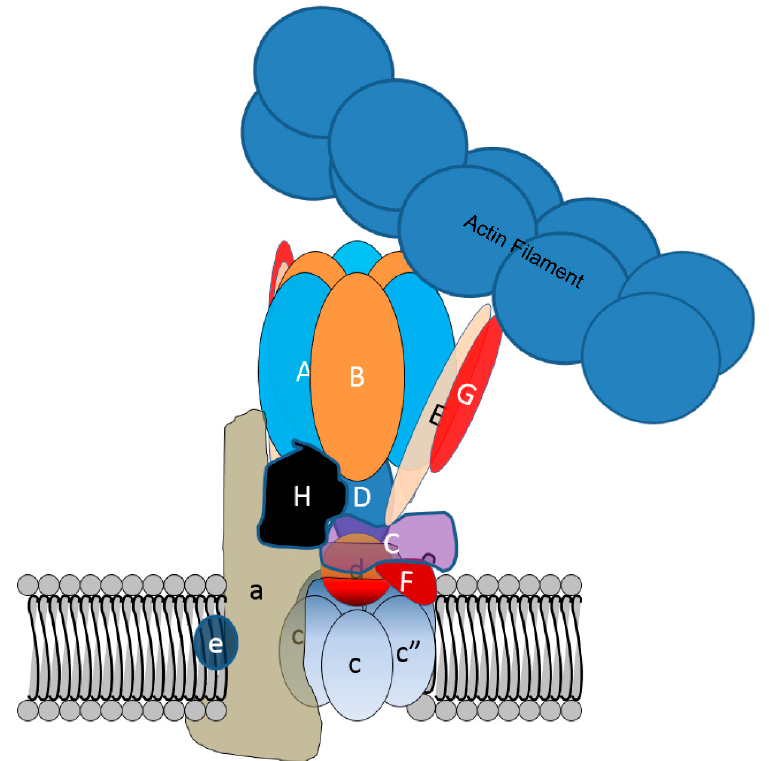
Figure 4. Despite a high affinity actin ‐ binding site in the B ‐ subunit of V ‐ ATPase, normally V ‐ ATPase does not bind microfilaments in cells. This is likely due to the actin binding site being covered by stator arms consisting of the E ‐ and G ‐ subunits. V ‐ ATPase binds microfilaments through an actin binding site in the B2 ‐ subunit in osteoclasts when the actin binding site is available. Whether this is due to a change in position of the arm as depicted, or by the loss of one or more stator arms, is not